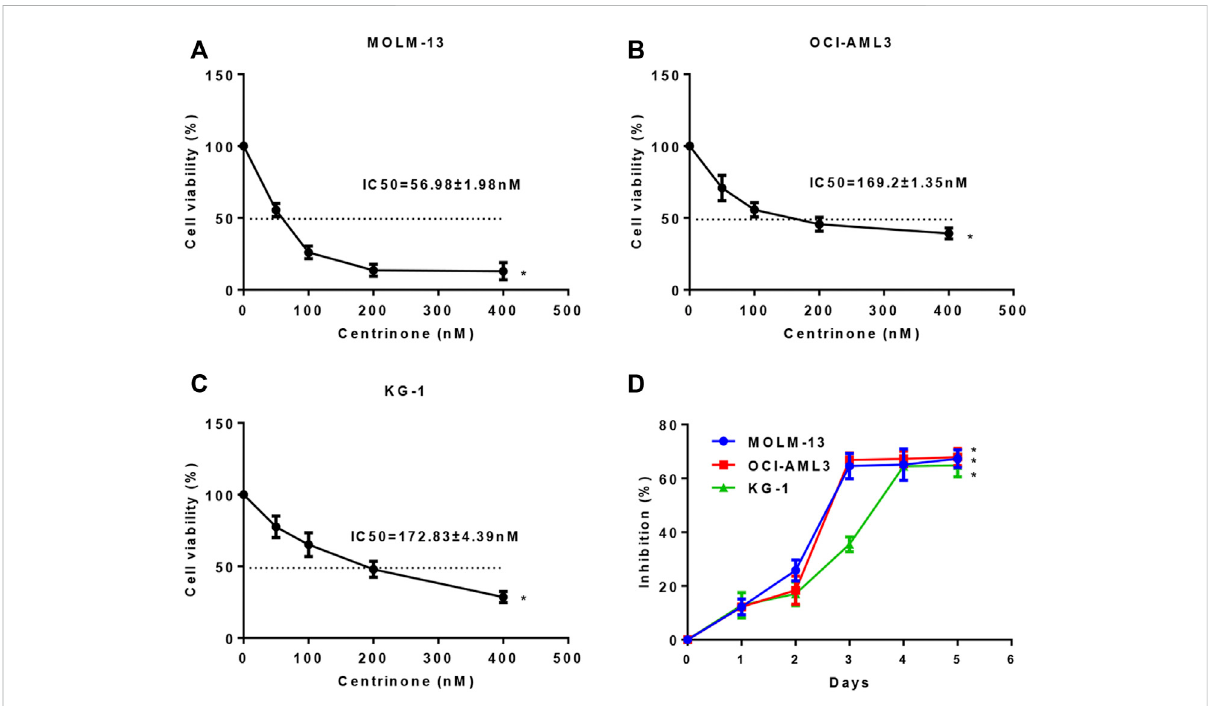
FIGURE 1 Centrinone inhibited the proliferation of AML cells in a dose- and time-dependent manner. (A – C) Effects of different Centrinone concentrations (0, 50, 100, 200, 400 nM) on the proliferation of AML cells were determined by treatment MOLM-13, OCI-AML3, and KG-1 cells for 72 h, then CCK-8was added, incubated for 3 h, fi nally theOD450 absorbance was detected. (D) The indicated Centrinoneconcentrations was used to treat MOLM-13 (54.26 nM), OCI-AML3 (177.7 nM), and KG-1 (189.9 nM) cells for 1-5 days to detect the effect of Centrinone on the proliferation of AML cells at different treatment times. Columns, means ( n ≥ 3); bars, SD . * p < 0.05 versus the control